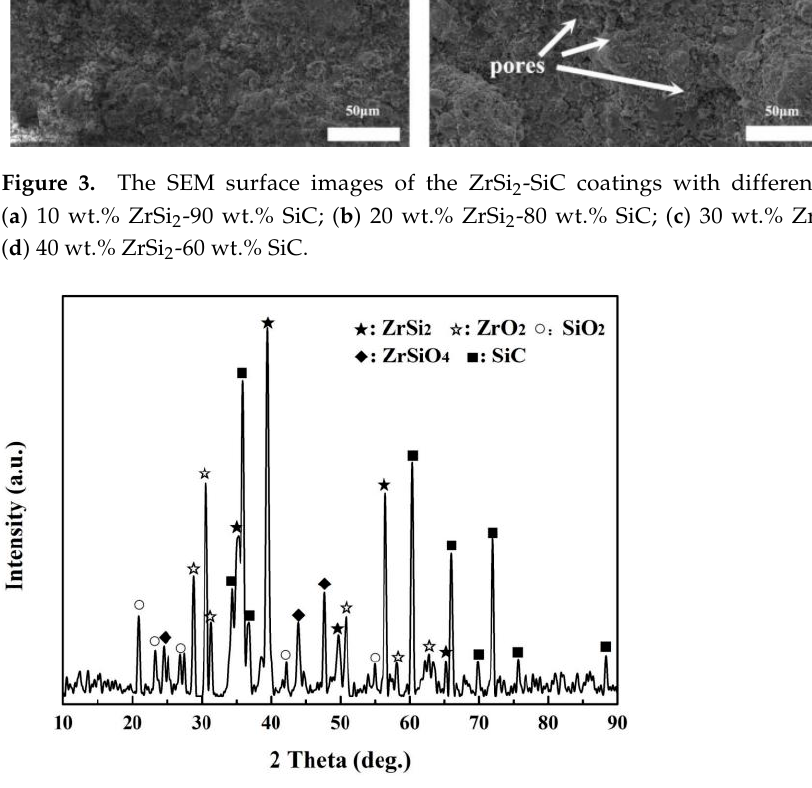
Figure 4. The XRD pattern of the 40 wt.% ZrSi 2 -60 wt.% SiC coating prepared by SAPS.